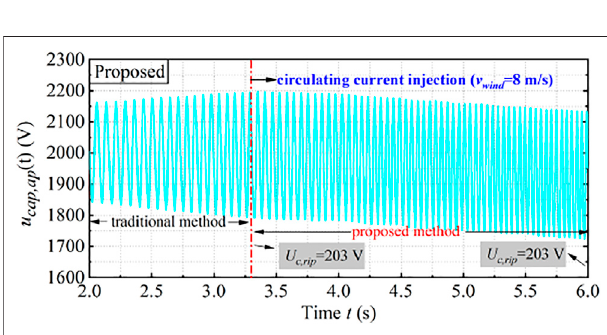
FIGURE 12 | Calculation results of circulating current amplitude.